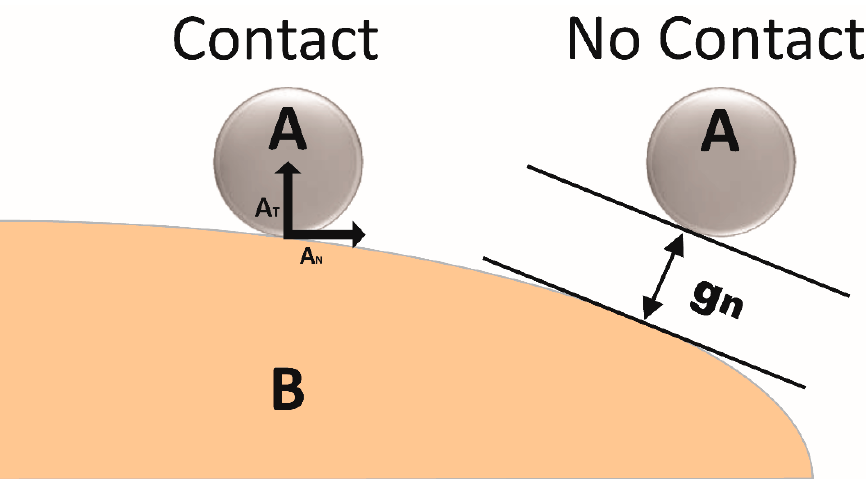
Figure 4. Schematic diagram of sliding contact between two bodies.